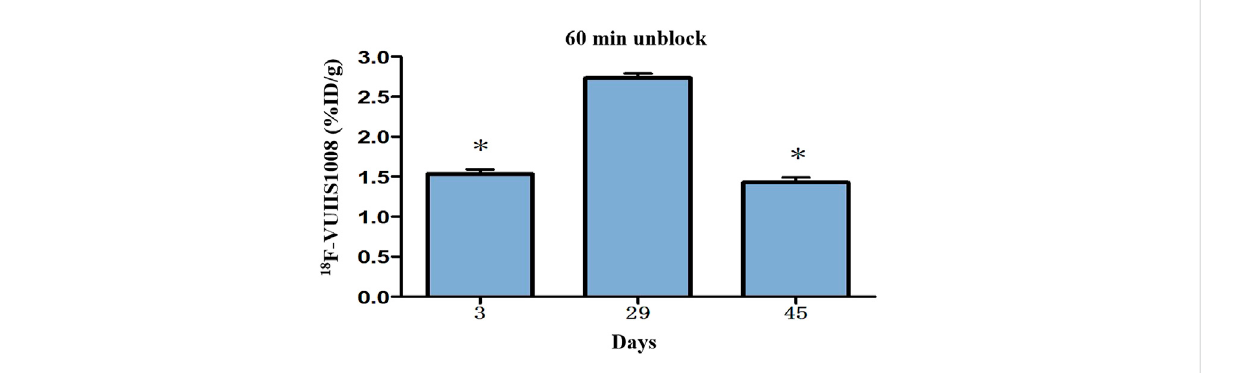
FIGURE 10 Quantitative analysis of 18 F-VUIIS1008 uptake in the left in fl ammatory ankles on day 3, 29, 45 based on PET imaging.